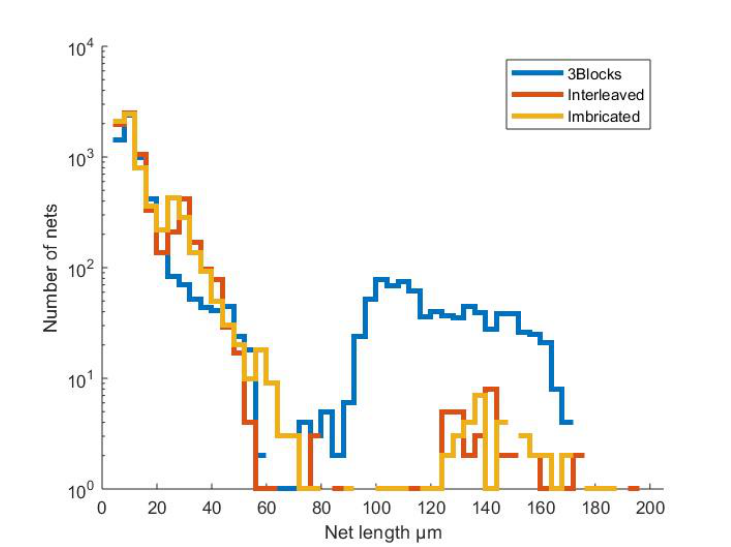
Figure 7. Net length histogram for the 8 × 16 bit design